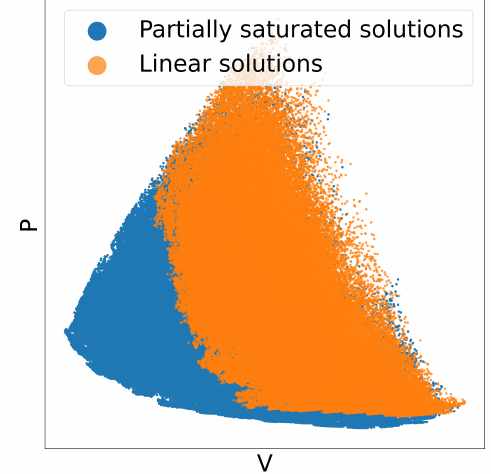
Figure 1. Qualitative comparison of the solutions evaluated considering the operation in linear and in partial saturation conditions, in the space of the total losses and the core volume. The maximum magnetic flux density considered for the linear operation is 0.2